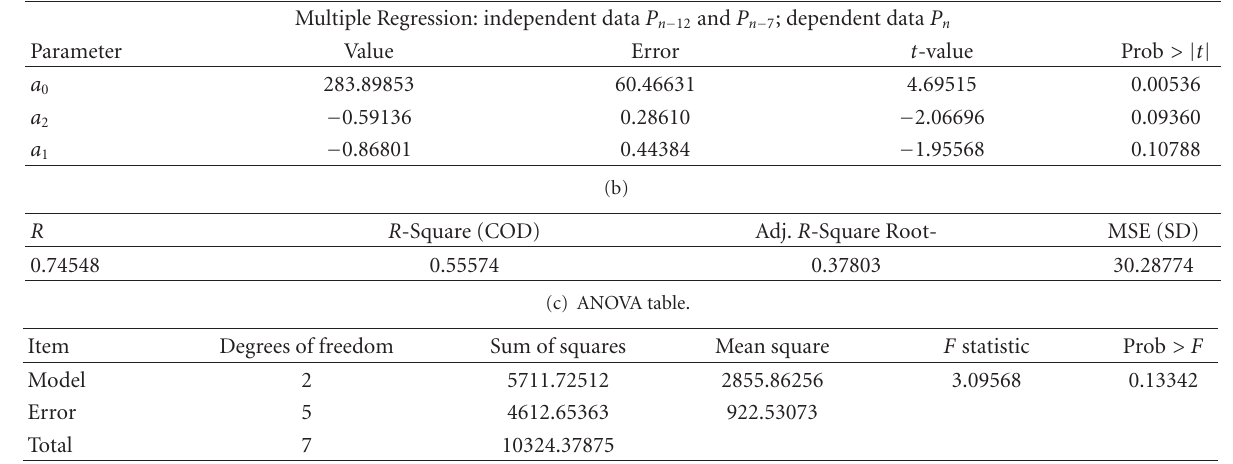
Table 2: Statistical results.